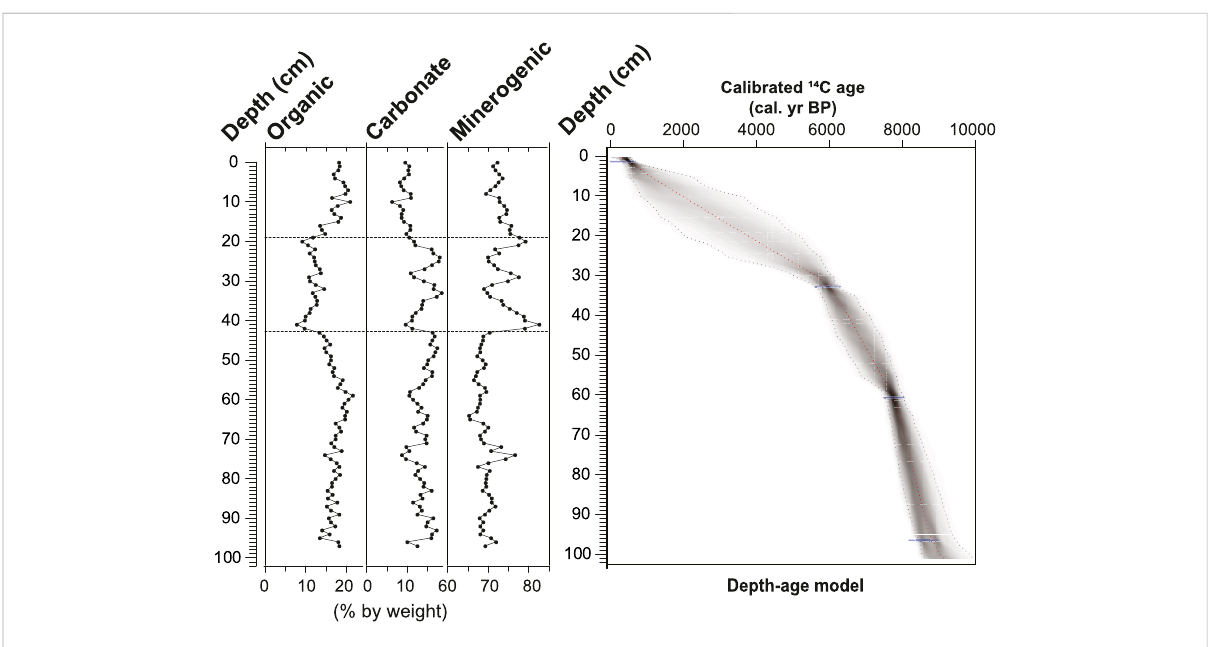
FIGURE 3 Results of loss-on-ignition analysis and depth-age model for the Xuguo Co